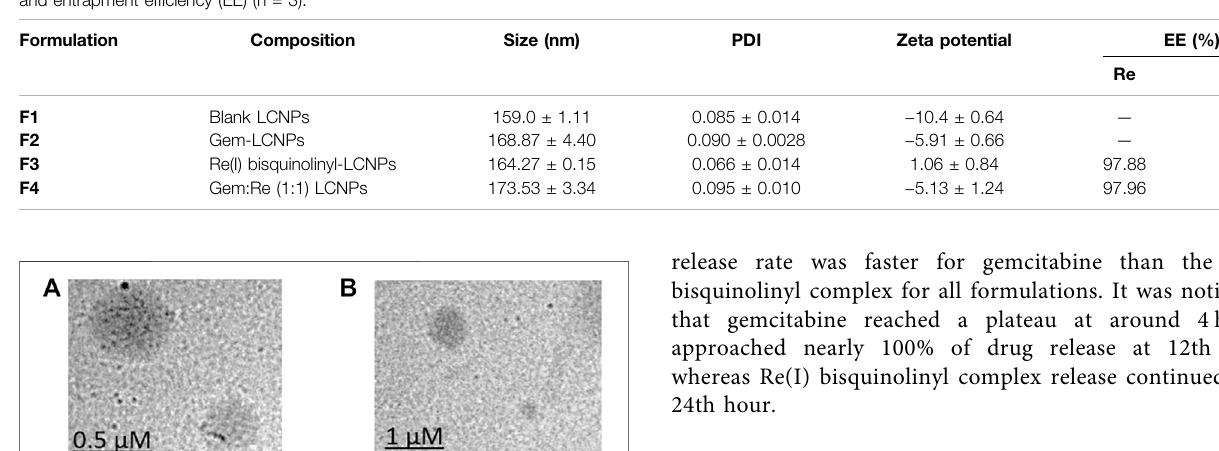
FIGURE5| TEMimagesof (A) BlankLCNPsand (B) LCNPsloadedwith gemcitabine and Re(I) bisquinolinyl complex at 1:1 ratio.